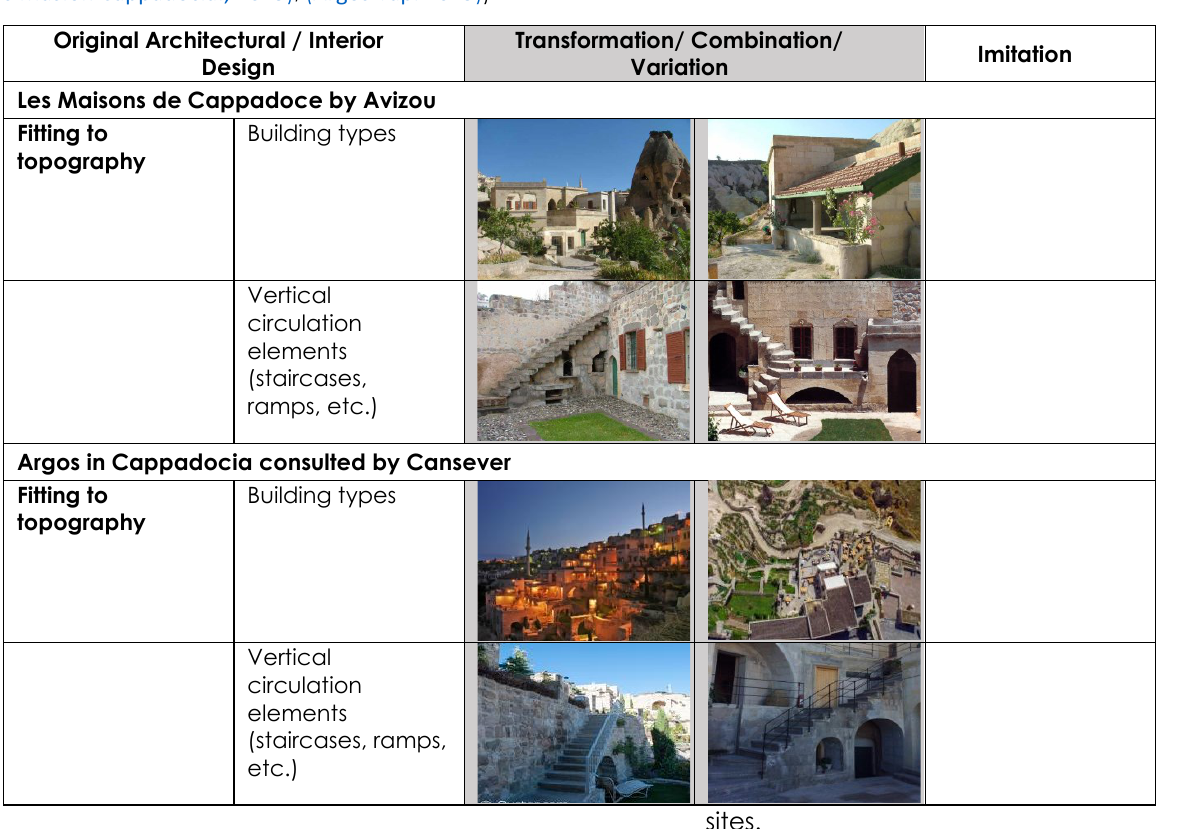
Table 5. Taxonomy of Design Guideline ‘Fitting to Topography’ according to Levels of Novelty . ( Les Masion Cappadocia., 2019 ), ( Argos Yapi 2019